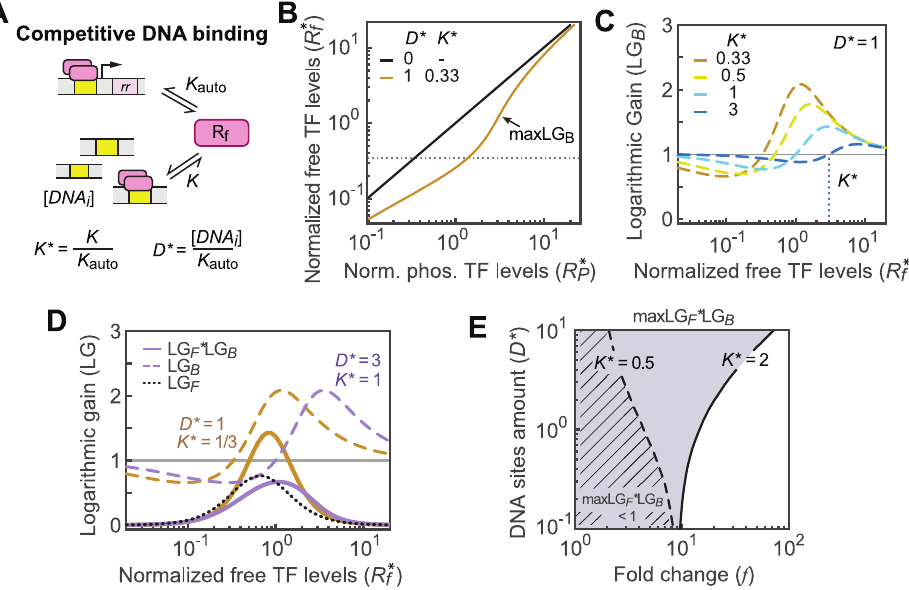
TFBSs. (B) Dependence of R f � on R p � in the absence (D � = 0) and presence (D � = 1) of competing TFBSs. The � = K � = 0.33. (C) Effects of the relative TFBS affinity on the logarithmic gain LG horizontal dotted line indicates R . f B The horizontal gray line corresponds to LG B = 1 when decoy TFBSs are absent. (D) Combined logarithmic gains of the autoregulation and DNA binding modules. Even with similar maximal LG values (purple and brown dashed lines), B the combined LG (solid lines) varies greatly depending on the relative TFBS affinity K � . (E) A phase diagram showing the parameter space for monostable systems with the maximal combined LG < 1. Solid and dashed lines represent the contour lines with maxLG LG = 1 at indicated K � values. When the relative affinity of TFBSs is weak ( K � = 2), a large F B monostable parameter space (gray shaded) is allowed, while stronger affinity ( K � = 0.5) leads to a smaller monostable space